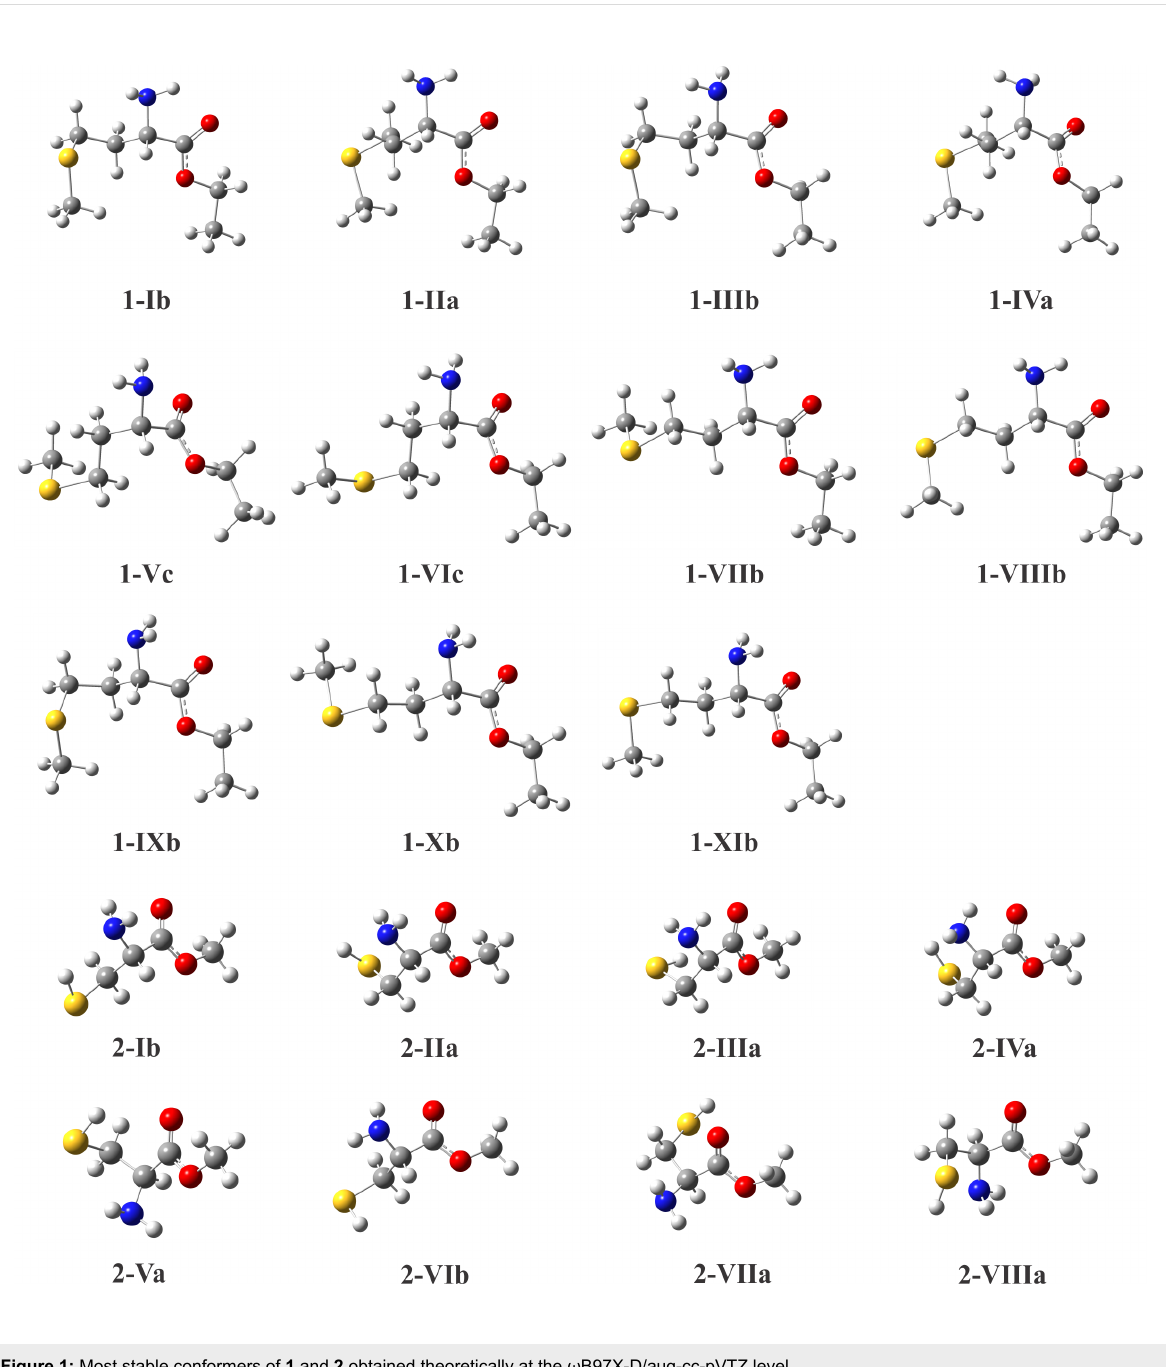
Furthermore, the conformers b of the compound 1 are favored in the conformational equilibrium, since their populations together are larger than 50% of the total population of 1 , in all different studied media. Although the global minimum of 1 is in the form b in gas phase and also in solution, the three more stable geometries ( 1-IXb , 1-Xb and 1-XIb ) in the former are substituted by three new structures ( 1-Ib , 1-VIIb and 1-VIIIb )